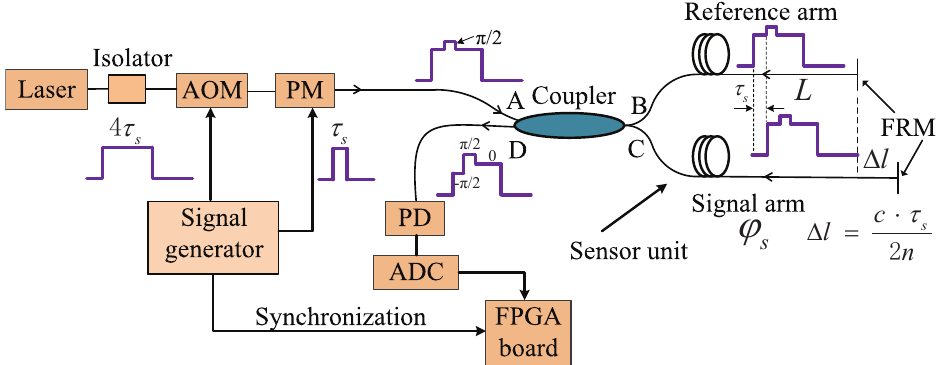
Figure 1. The principle of the RPB